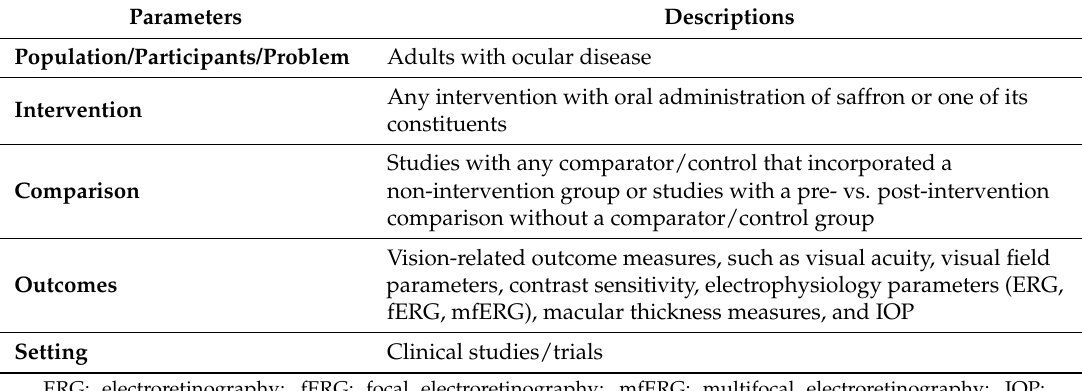
Table 1. Predefined PICOS (Population/Participants/Problem, Intervention, Comparators, Outcomes, Study Design) criteria that were followed in order to identify and include clinical studies in the present